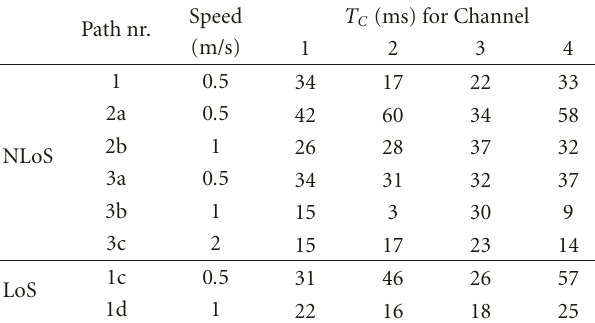
Table 2: Coherence time for measured channels. Path nr.